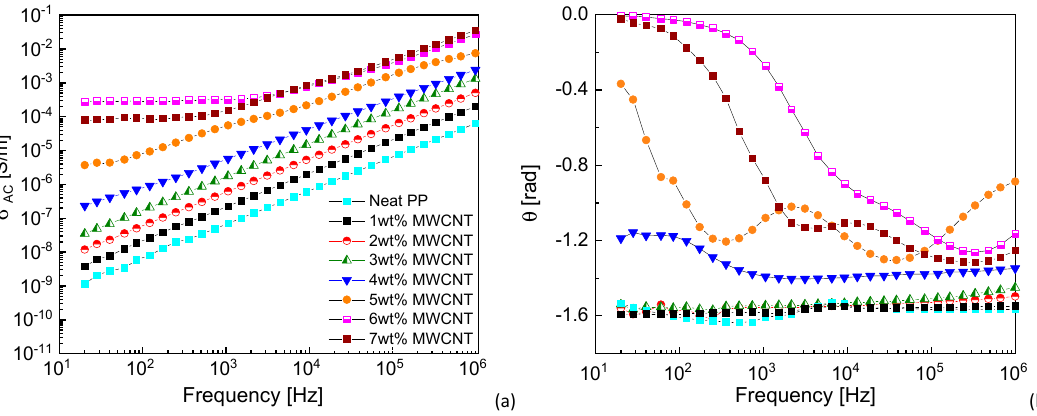
Figure 2. ( a ) AC electrical conductivity and ( b ) phase angle of the neat PP and the studied nanocomposites (tests performed in P1; graph legend reported in ( a ) is valid also for ( b )).